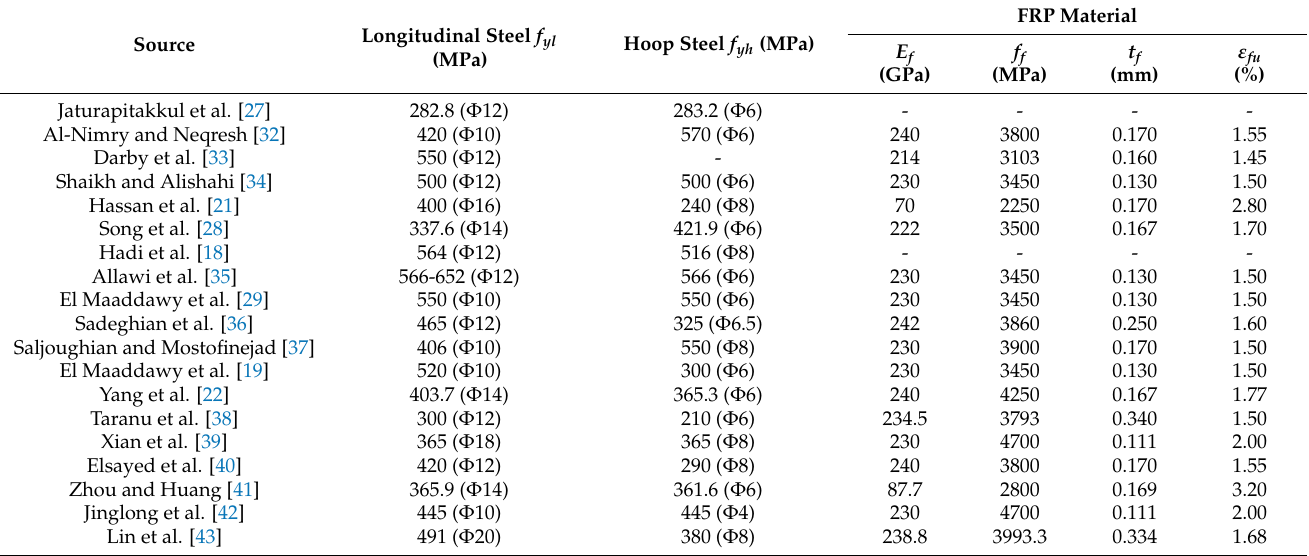
Table 3. Mechanical properties of steel reinforcement and FRP